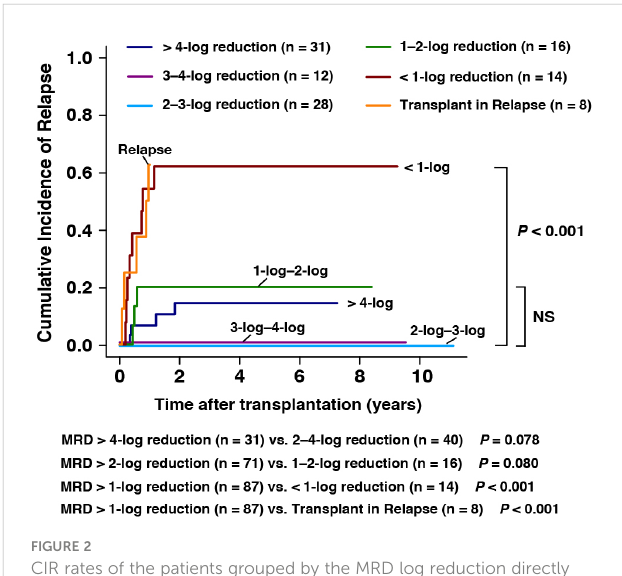
CIR rates of the patients grouped by the MRD log reduction directly before